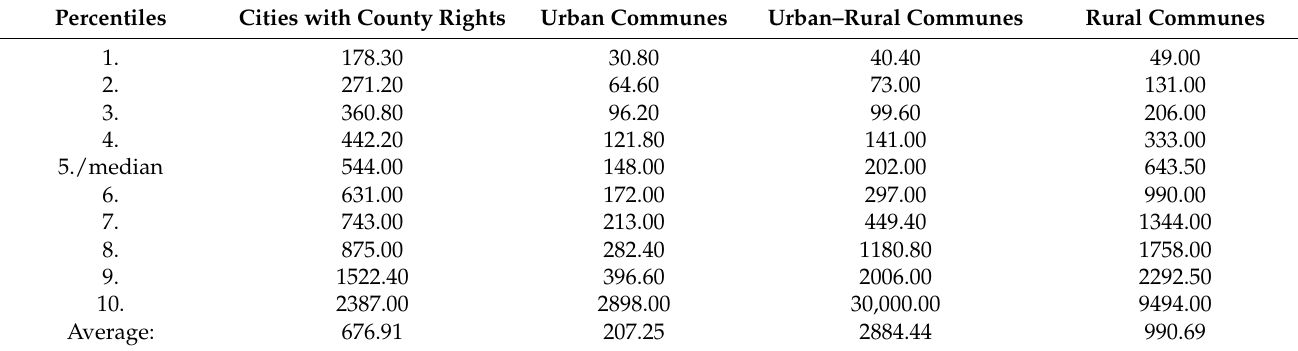
Table 9. Percentiles and the average size of the revitalisation area in the respective types of the communes (ha). Percentiles